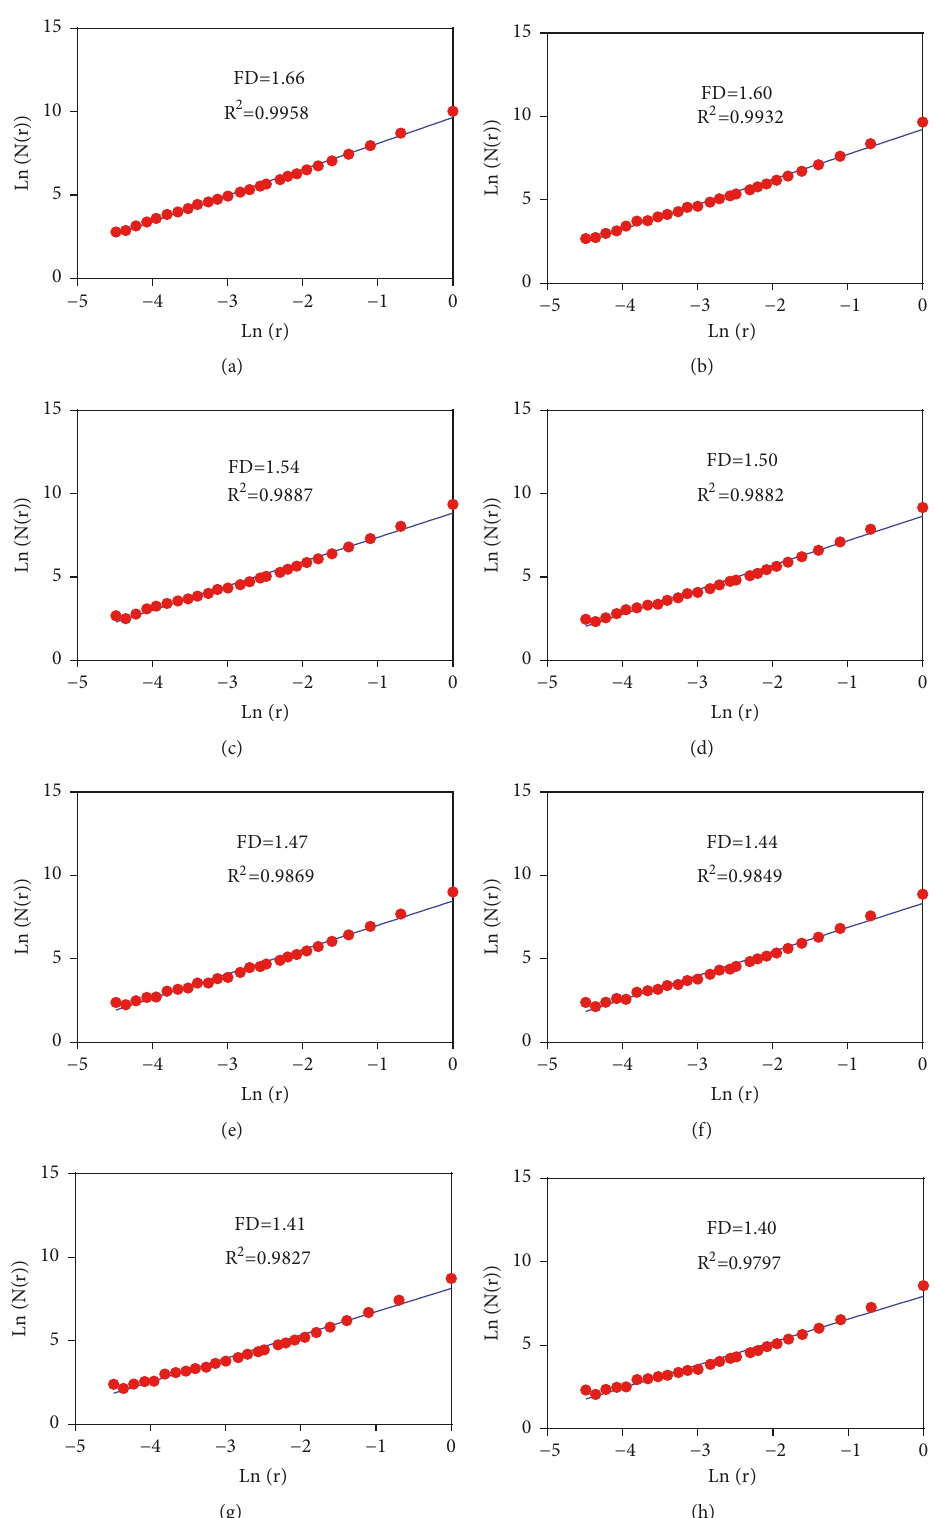
Figure 9: HarFA 5.5 plots showing the number of boxes N(r) against box side length (r) on logarithmic scales for each map in Figure 7. (a) Ω .m; (b) (cid:2) Ω .m; (c) (cid:2) Ω .m; (d) (cid:2) Ω .m; (e) (cid:2) Ω .m; (f) (cid:2) Ω .m; (g) (cid:2) Ω .m; (h) (cid:2) Ω (cid:2) a . r = 200 a . r = 220 a . r = 240 a . r = 260 a . r = 280 a . r = 300 a . r = 320 a . r = 340